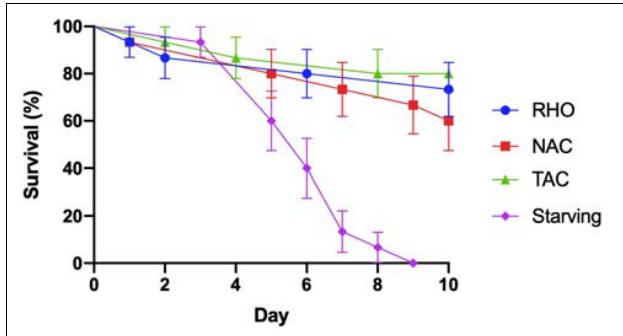
FIGURE 1 | Acartia tonsa survival when exposed to RHO ( Rhodomonas sp.; blue circles), TAC (toxic Alexandrium catenella 1119/27; green triangles), and NAC (non-toxic A. catenella 1119/19; red squares) at a concentration of 1,000 µ g C L − 1 or when starved (purple diamond). Dots ( N = 15) are mean value, and error bars show the standard error (SE).